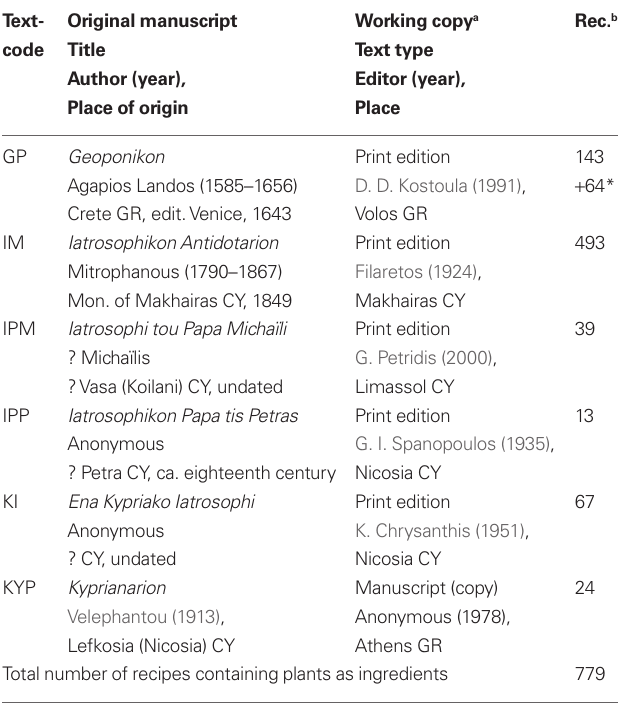
Table 1 | The six investigated iatrosophia